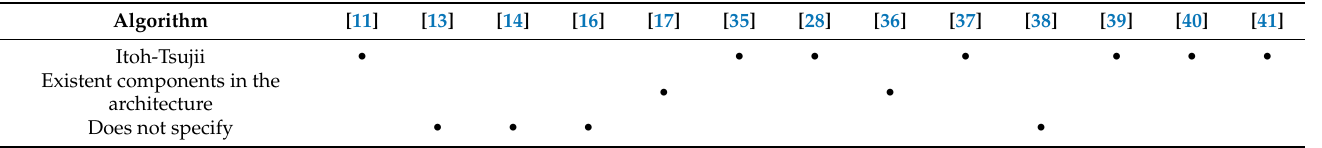
Table 8. Inversion